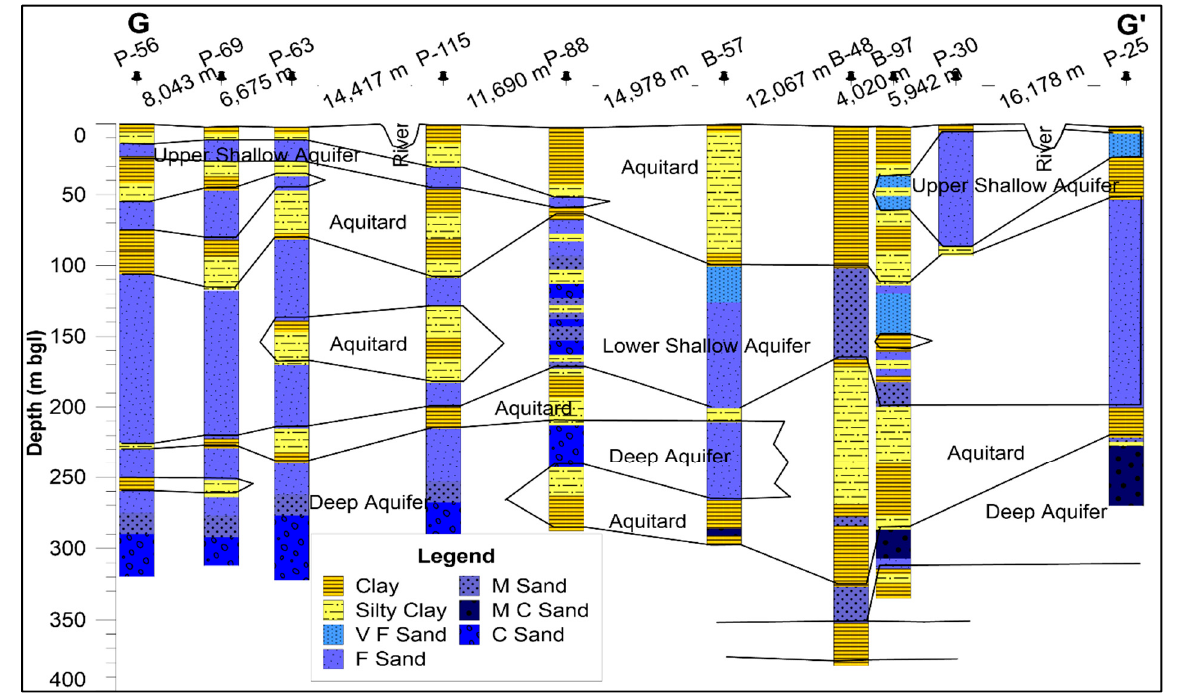
Figure 2. Hydrostratigraphic cross-section along the line G-G’ (Figure 1).